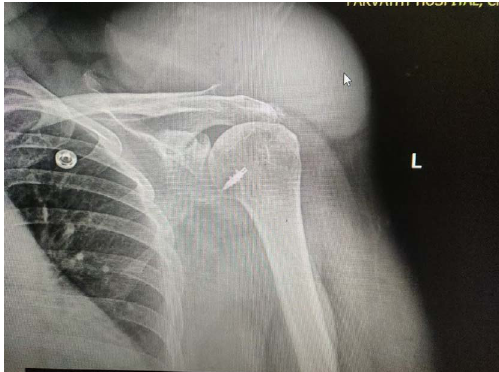
Figure 2. X-ray of the affected shoulder showing destruction of AC joint and metal anchor in-situ.